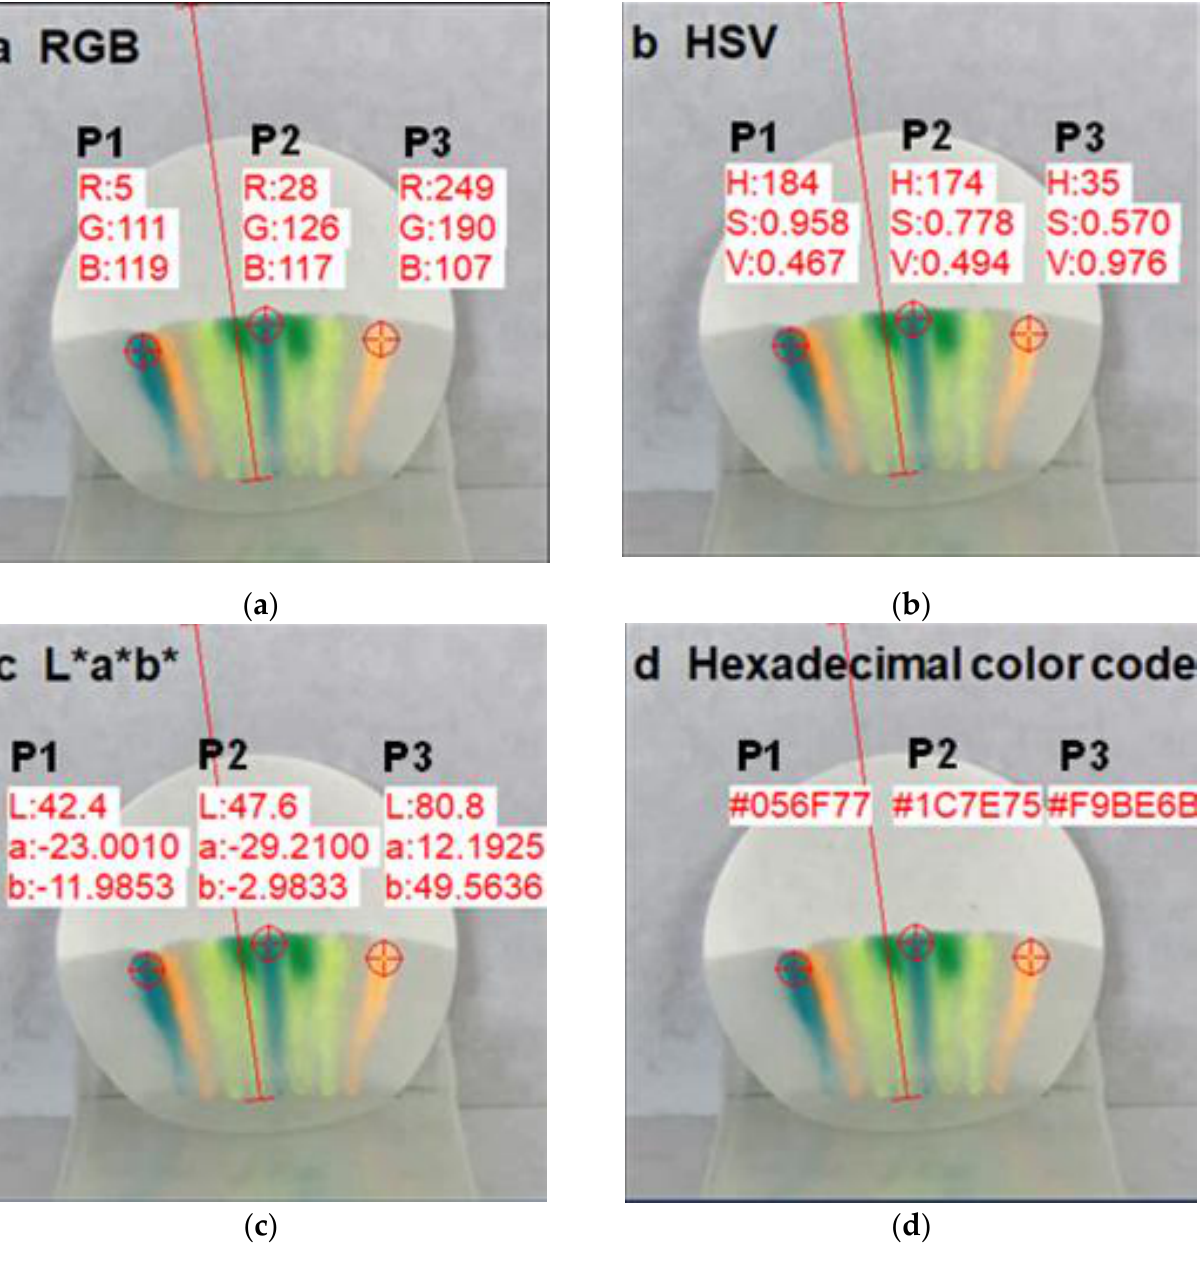
Figure 3. Examples of color conversion of three points (P1, P2 and P3) on the image displayed on the screen between color systems. ( a ) RGB; ( b ) HSV; ( c ) L*a*b*; and ( d ) hexadecimal color code.